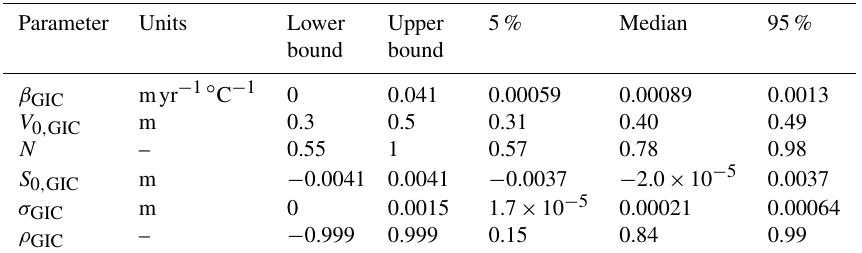
Table A5. Prior probability distribution ranges for the GIC- MAGICC Glaciers and Ice Caps model parameters, and median, 5th, and 95th quantiles of the calibrated posterior parameter distri- butions. The priors are all uniformly distributed.